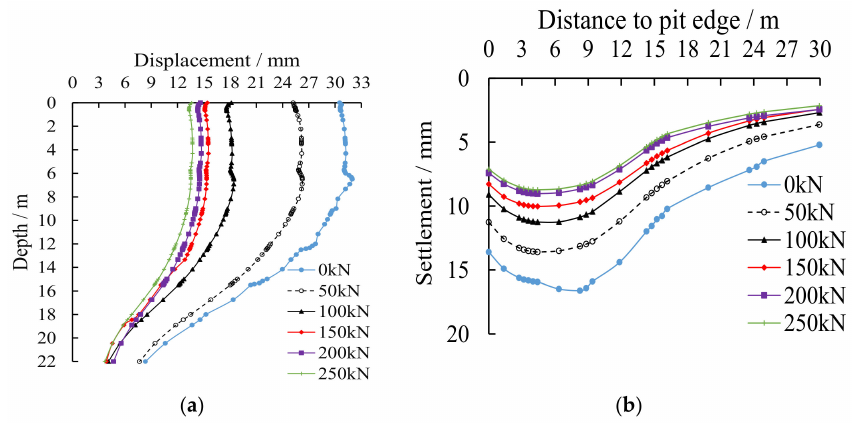
Figure 25. Influence curves of different prestress: ( a ) Horizontal displacement of piles,( b ) Ground settlement.